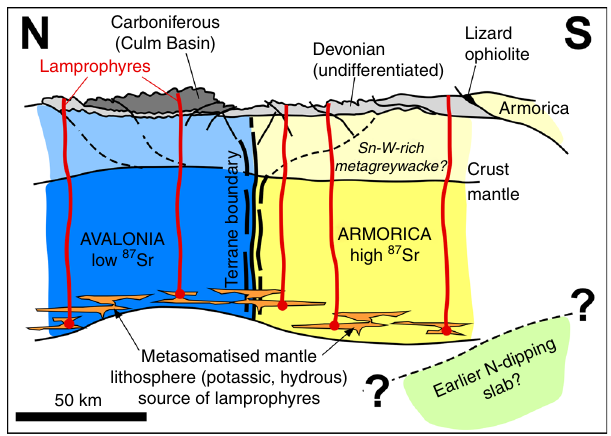
Fig. 4 Schematic north – south cross-section showing the terrane boundary around the time of emplacement of the lamprophyres (c. 290 Ma), after the Variscan Orogeny. Armorican mantle lithosphere in yellow with characteristic high 87 Sr/ 86 Sr is juxtaposed against Avalonian mantle lithosphere in blue. Both domains had been affected by potassic-hydrous metasomatism (orange veins in basal part of the lithosphere), possibly above a (north-dipping?) subduction zone. These metasomatised mantle rocks formed the source for the lamprophyres on both sides. Deepest- derived lamprophyric magmas are formed on either side of a central area of thinned lithosphere. Dashed lines in lower crust denote inferred basement faults which controlled the segmentation of the Devonian sedimentary basins and which were re-activated as thrusts during the Variscan Orogeny. Upper crustal rocks (after published cross-section 42 ) mainly comprised of Devonian and Carboniferous sedimentary rocks were probably deposited after terrane juxtaposition and are shown in grey